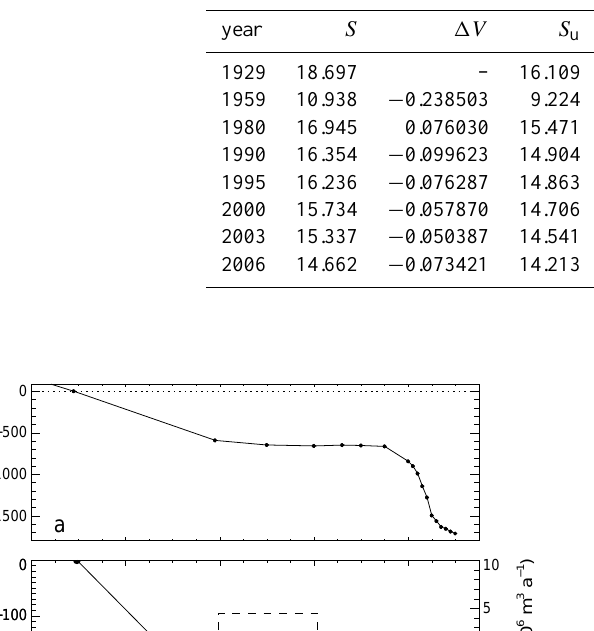
Table 3. Surface areas (km 2 ) for the whole glacier ( S ) and for its upper ( S u ) and lower part ( S ‘ ). 1V : corresponding ice volume changes (km 3 ).